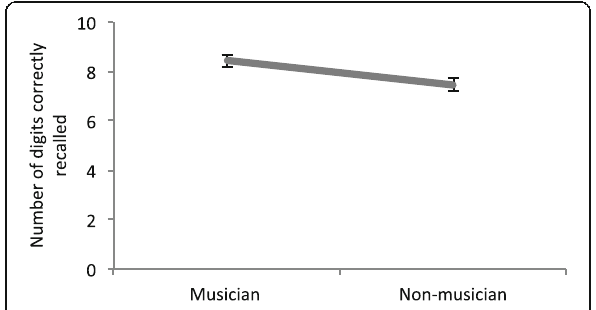
Fig. 2 Musician status in the digit span backward task. Musicians